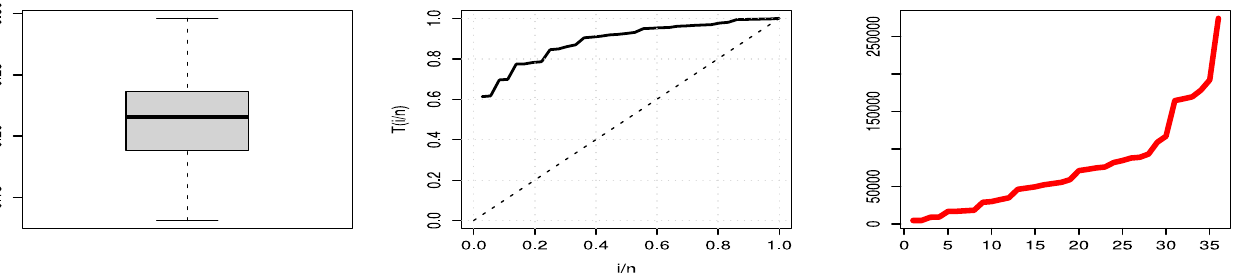
Figure 9 shows three plots of COVID ‐ 19 mortality rates for the Saudi Arabia data set,